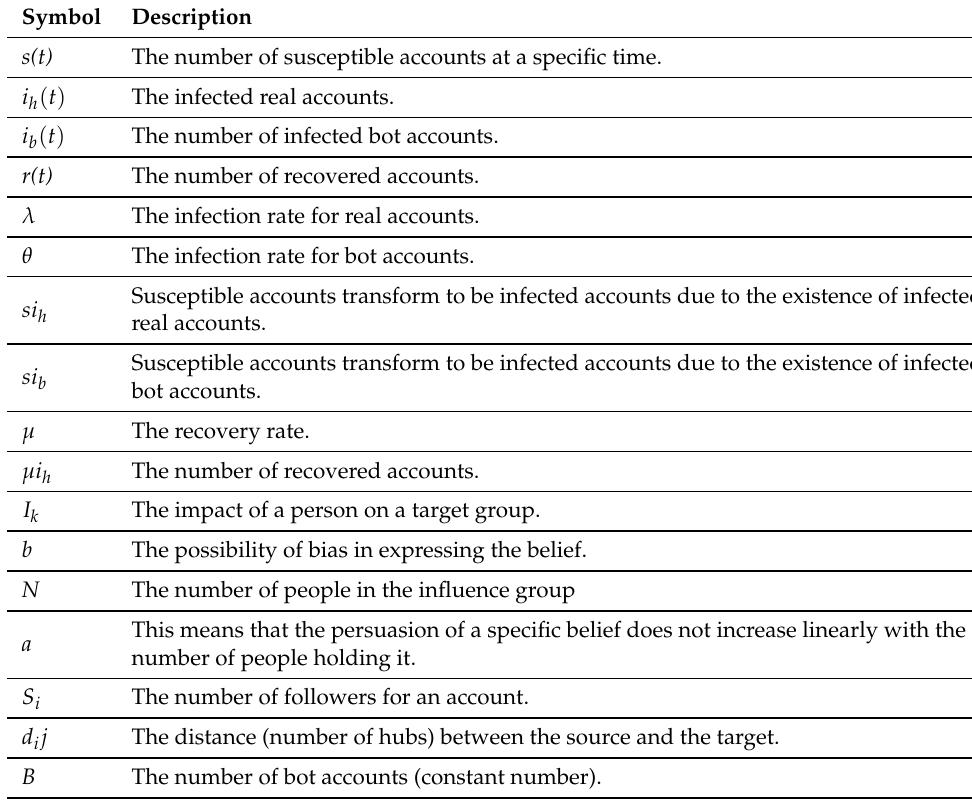
Table 4. Symbol Description for SI h I b R Model, Social Impact Theory, and Closeness Centrality.